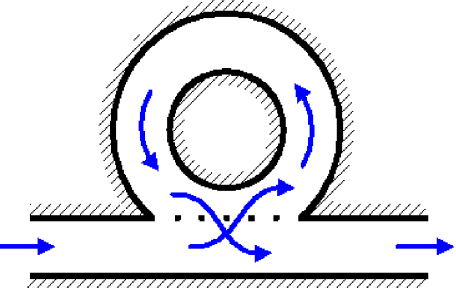
FIG. 3. (Color) An equivalent scheme based on traveling-wave cavity and directional coupler.